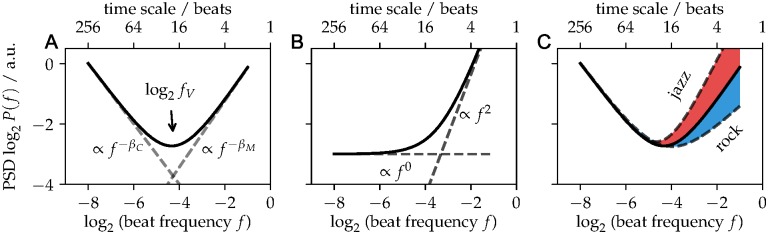
Scheme of the power-spectral density (PSD) of inter-beat interval (IBI) time series.A. The combination of a long-range correlated clock and motor process (dashed lines) superpose to a V-shaped PSD of the IBIs (solid line). The characteristic frequency (or time scale, see upper axis) at the minimum determines the turnover between the clock-dominated and motor-dominated regime. B. Same as panel A, but assuming that both, the clock and motor process are uncorrelated. C. Sketch of genre-induced differences in the PSD.